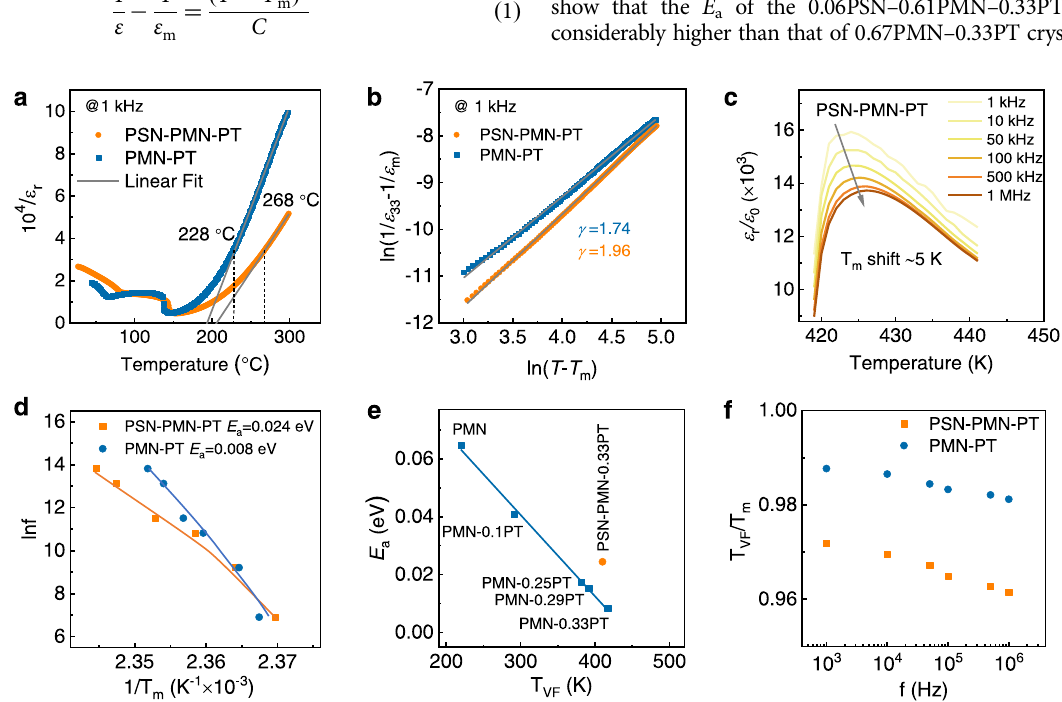
Fig. 3 Relaxor behavior. a Temperature dependence of the reciprocal of dielectric permittivity, from which T B is obtained by fi tting with the modi fi ed Curie – Weiss law. b Modi fi ed Curie – Weiss law fi tting results, from which γ can be obtained. c High-temperature dielectric property of 0.06PSN – 0.61PMN – 0.33PT crystals measured at various frequencies from 1kHz to 1MHz. d Vogel – Fulcher fi tting results on the data shown in Fig. 3c and Fig. S7, from which the activation energy E a and static freezing temperature T VF can be determined. e Summary of E a for various pure PMN, PMN – PT, and PSN – PMN – PT. Data are from refs. 25, 68, 69 . and this work. f T VF / T m value as a function of frequency for 0.67PMN – 0.33PT and 0.06PSN – 0.61PMN –